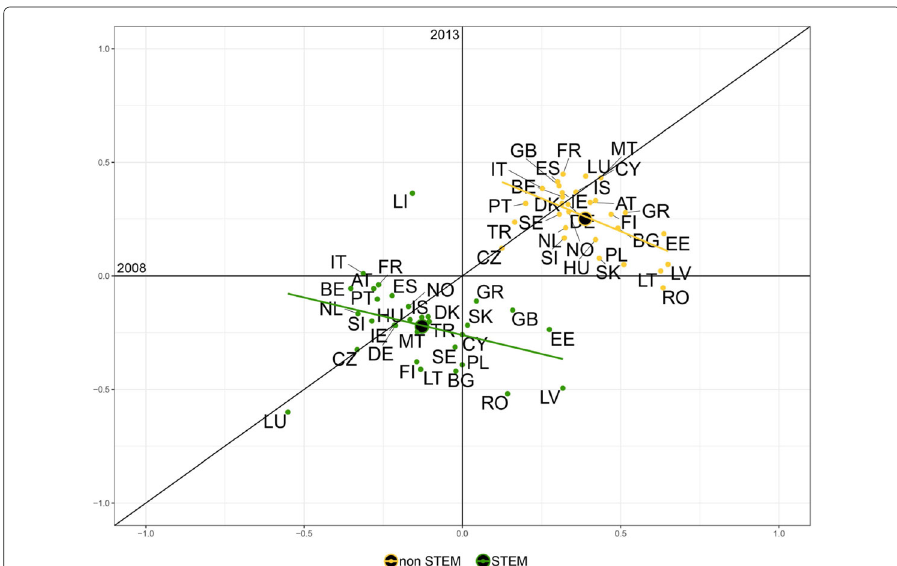
Fig. 5 Gender balance in the incoming flows of students enrolled in STEM vs. non-STEM disciplines for the year 2008 against 2013. The scatter plot shows the F / M B measure for the incoming flows of students for the years 2008 and 2013 by area of study. The STEM field is derived by summing the number of students in mobility in Engineering,manufacturingandconstruction , ICTs and Naturalsciences,mathematicsandstatistics , as coded following the ISCED-F 2013 classification. Non-STEM disciplines include Agriculture,forestry,fisheries andveterinary,ArtsandHumanities,Business,administrationandlaw,Education,Healthandwelfare,Services, Socialsciences,journalismandinformation . The fields Notknownorunspecified and Genericprogramsand qualifications are not included in either the two groups. The fitted lines are robust to outliers and pass through the averages (black dot) of the two